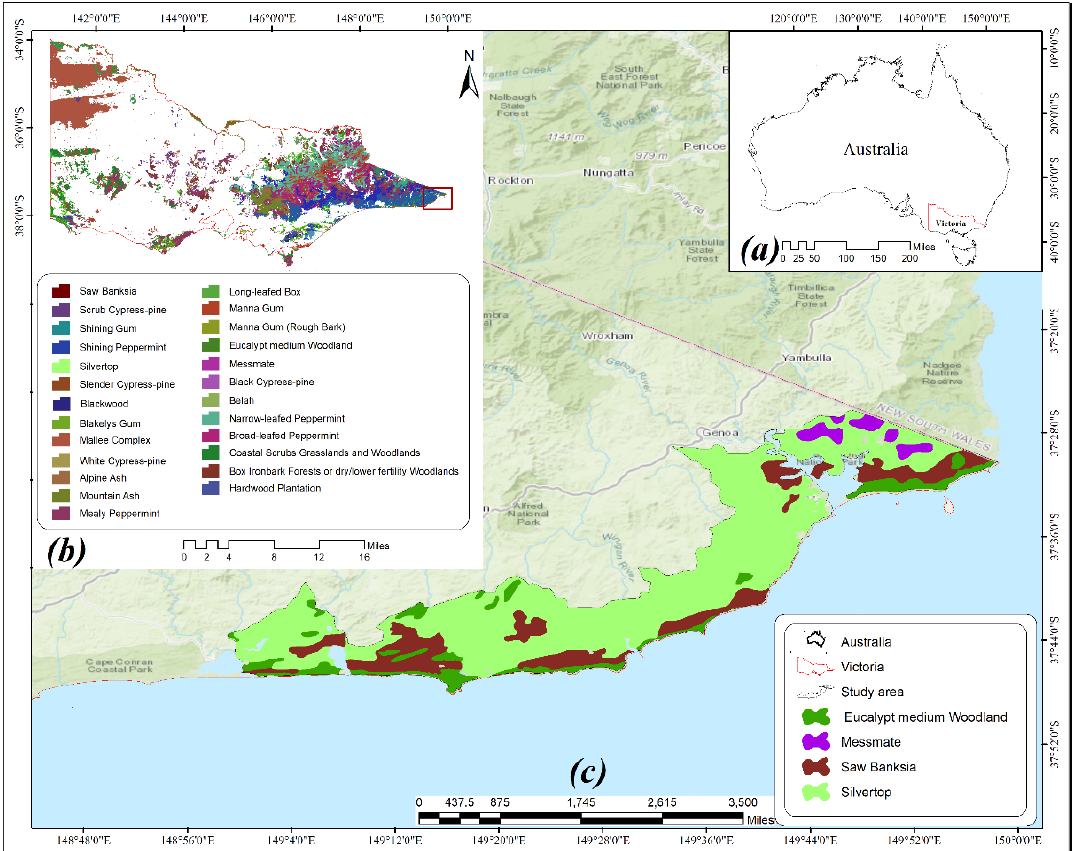
Figure 1. Geographic location of the study area: ( a ) the study area in Australia, ( b ) main forest distribution in Victoria, Australia, and ( c ) geographical location and main forest distribution in the study